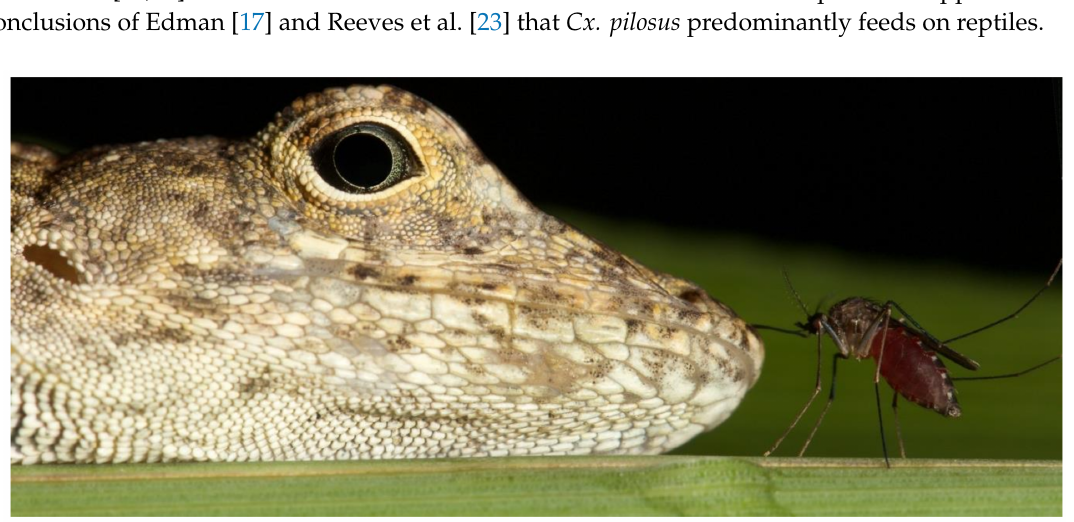
Figure 3. Female Culex pilosus feeding from Anolis sagrei at Blue Cypress Lake, Indian River County, Florida, USA, 8 July